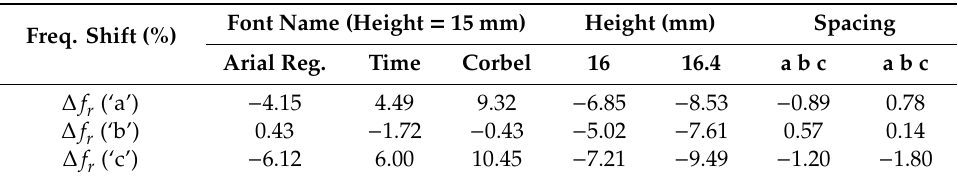
Table 2. Summary of the frequency shifts in co-polar-HH achieved with the simulated parameters of designed tags (frequency shift is expressed in